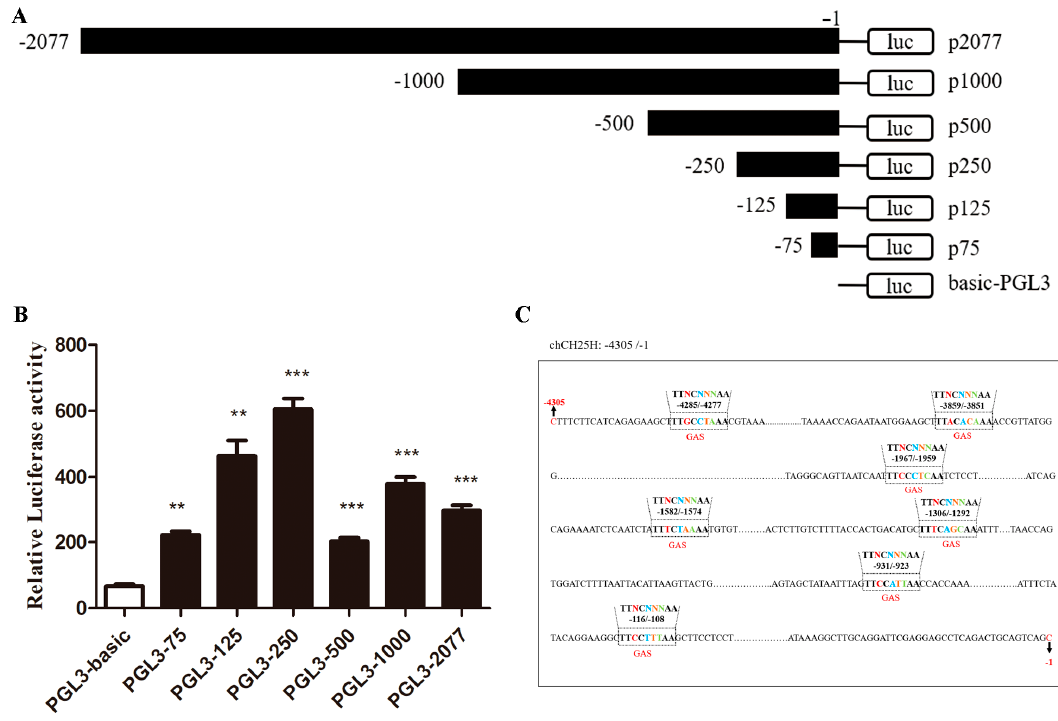
Figure 4. Analysis of the core promoter of chCH25H . ( A ) The first nucleotide of chCH25H coding region is numbered − 1, and the di ff erent dual luciferase reporter vectors are named PGL3- p2077( − 2077 / − 1), p1000 ( − 1000 / − 1), p500 ( − 500 / − 1), p250 ( − 250 / − 1), p125 ( − 125 / − 1) and p75 ( − 75 / − 1), respectively. ( B ) Dual luciferase assay showed that the inserted sequences of 75 bp, 125 bp, 250 bp, 500 bp, 1000